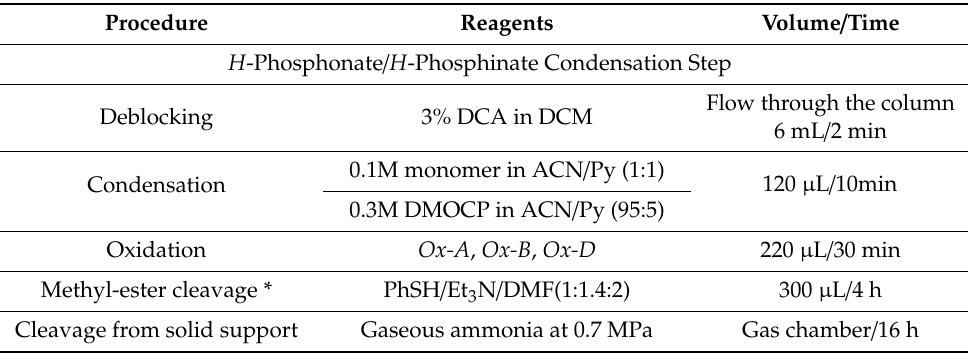
Table 4. Synthetic Protocol A (For more details see Supporting Information).